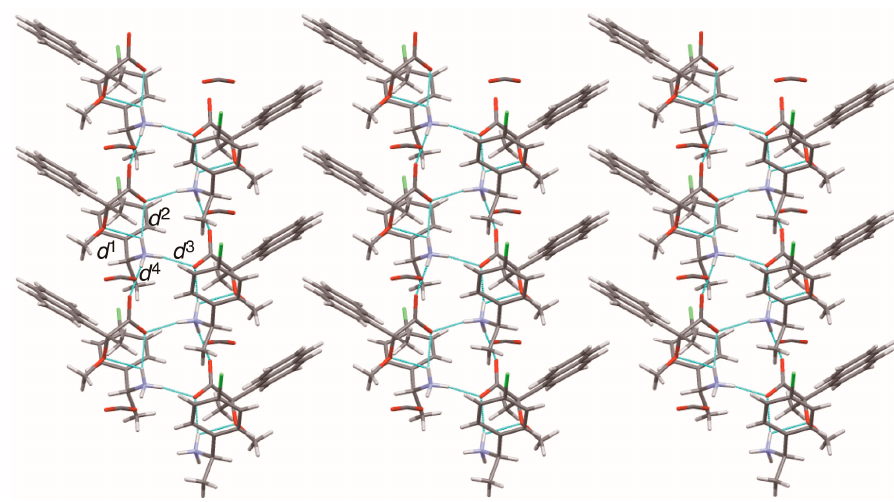
Figure 10. Sheet structure in crystalline salt 8 , consisting of 2 1 columns. The pale-blue lines show salt bridges and hydrogen bonds. See Table 3 for the interatomic distances d 1 – d 4 .